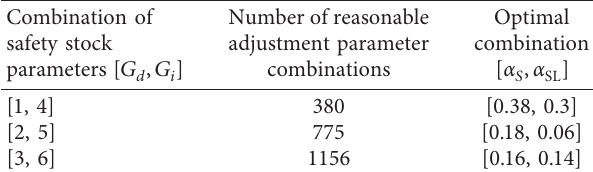
Table 4: The number and optimal combination of reasonable adjustment parameter combinations under the scenario of random demand obeying normal distribution from local